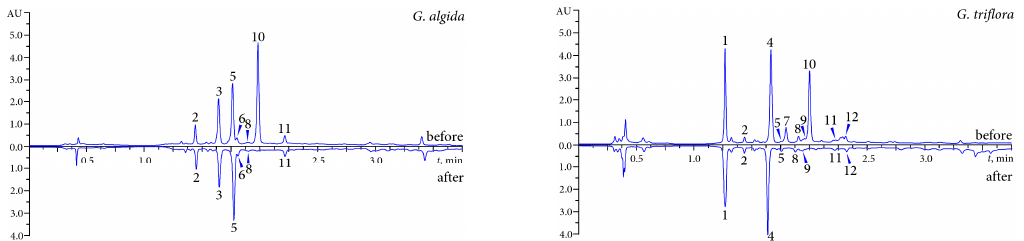
Figure 3. HPLC chromatograms of G. algida and G. triflora teas decoctions before and after prechromatographic reaction with DPPH-radicals. Compounds: 1 —loganic acid-6 ′ - O - β - D -glucoside;